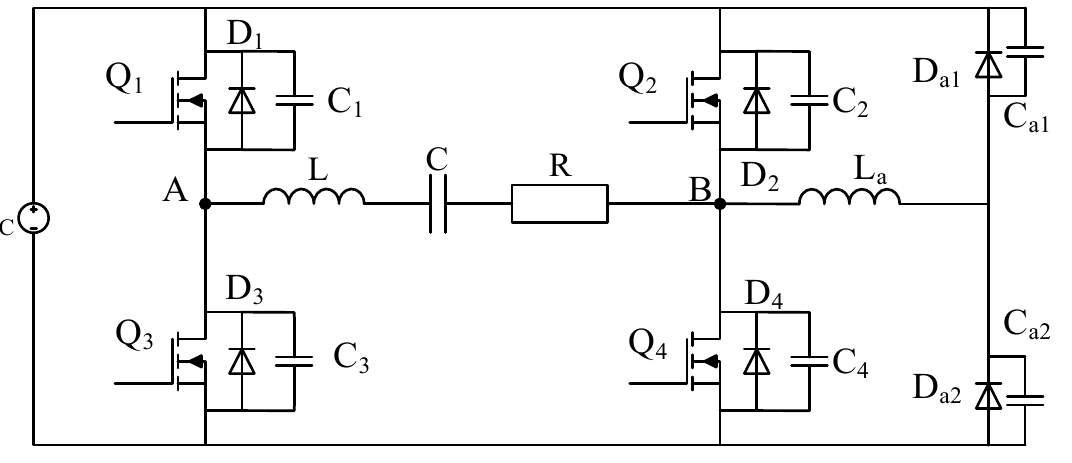
Figure 1. Diagram of Full bridge inverter structure.